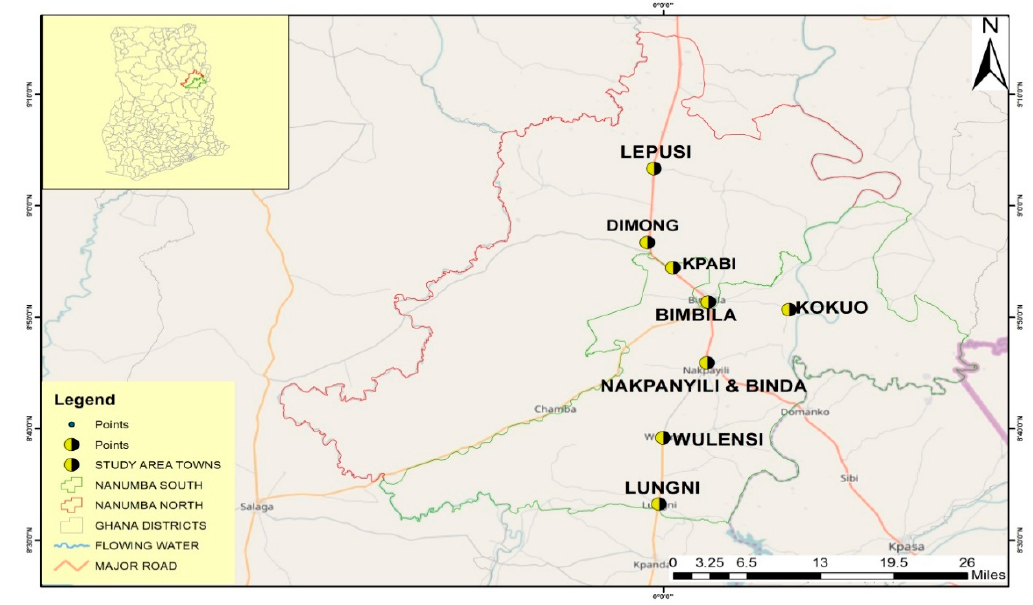
Figure 1. Map of study area.